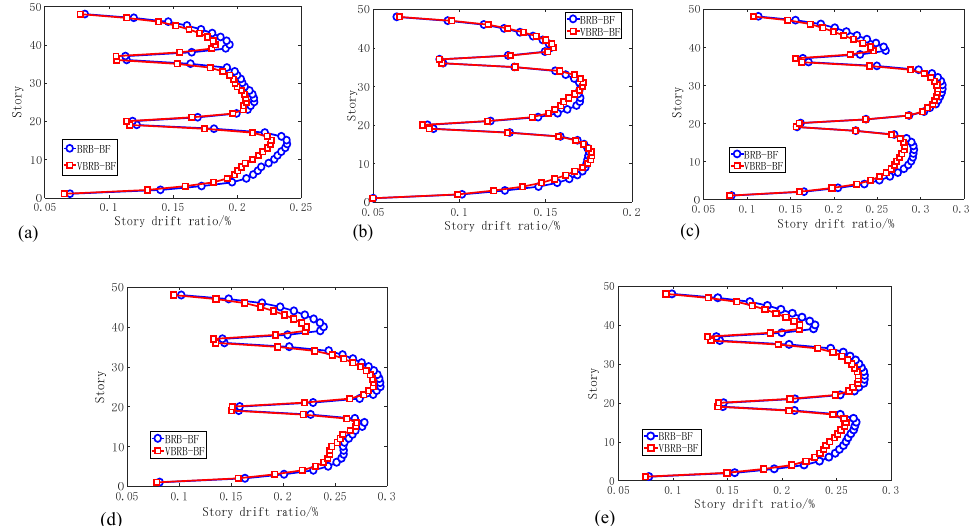
Figure 10. Responses of the maximum lateral drift ratio (PGA = 70 cm/s 2 ) underground motions: ( a ) El Centrol; ( b ) Imperial Valley-06; ( c ) Loma Prieta; ( d ) artificial; and ( e ) average response.